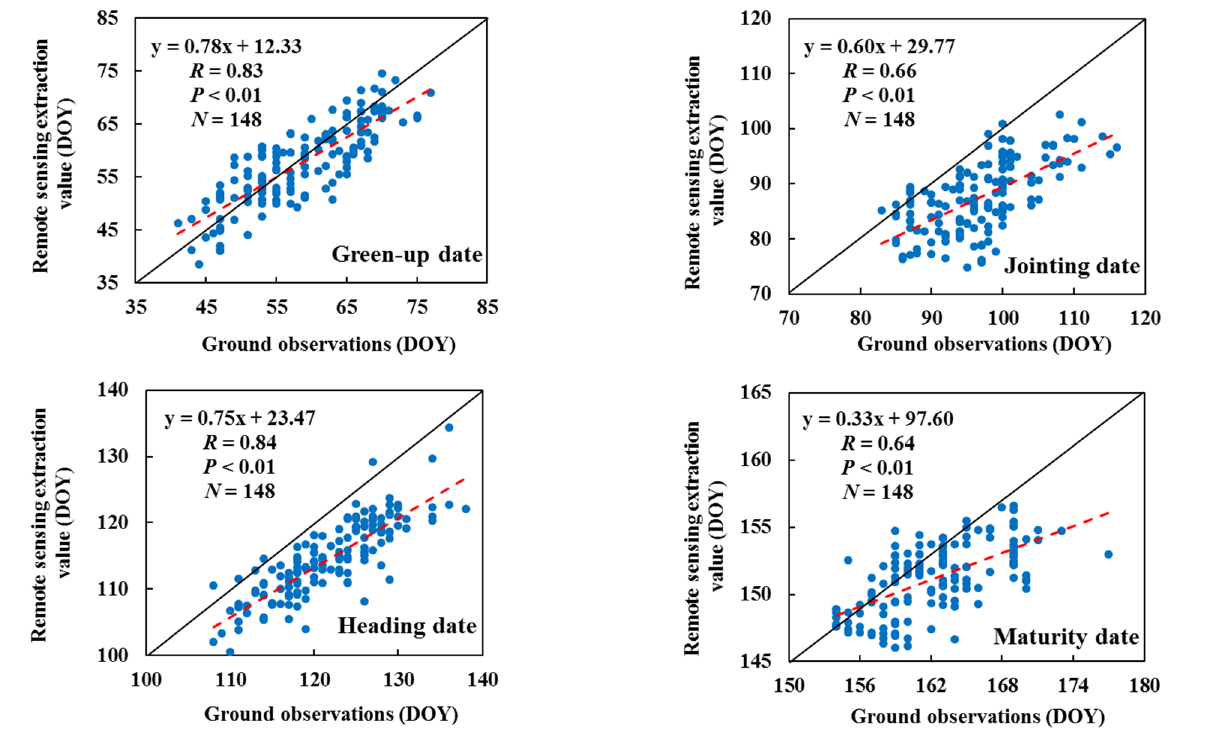
Figure 4. Comparison between satellite-based winter wheat phenological stages and ground obser- Figure 4. vations.